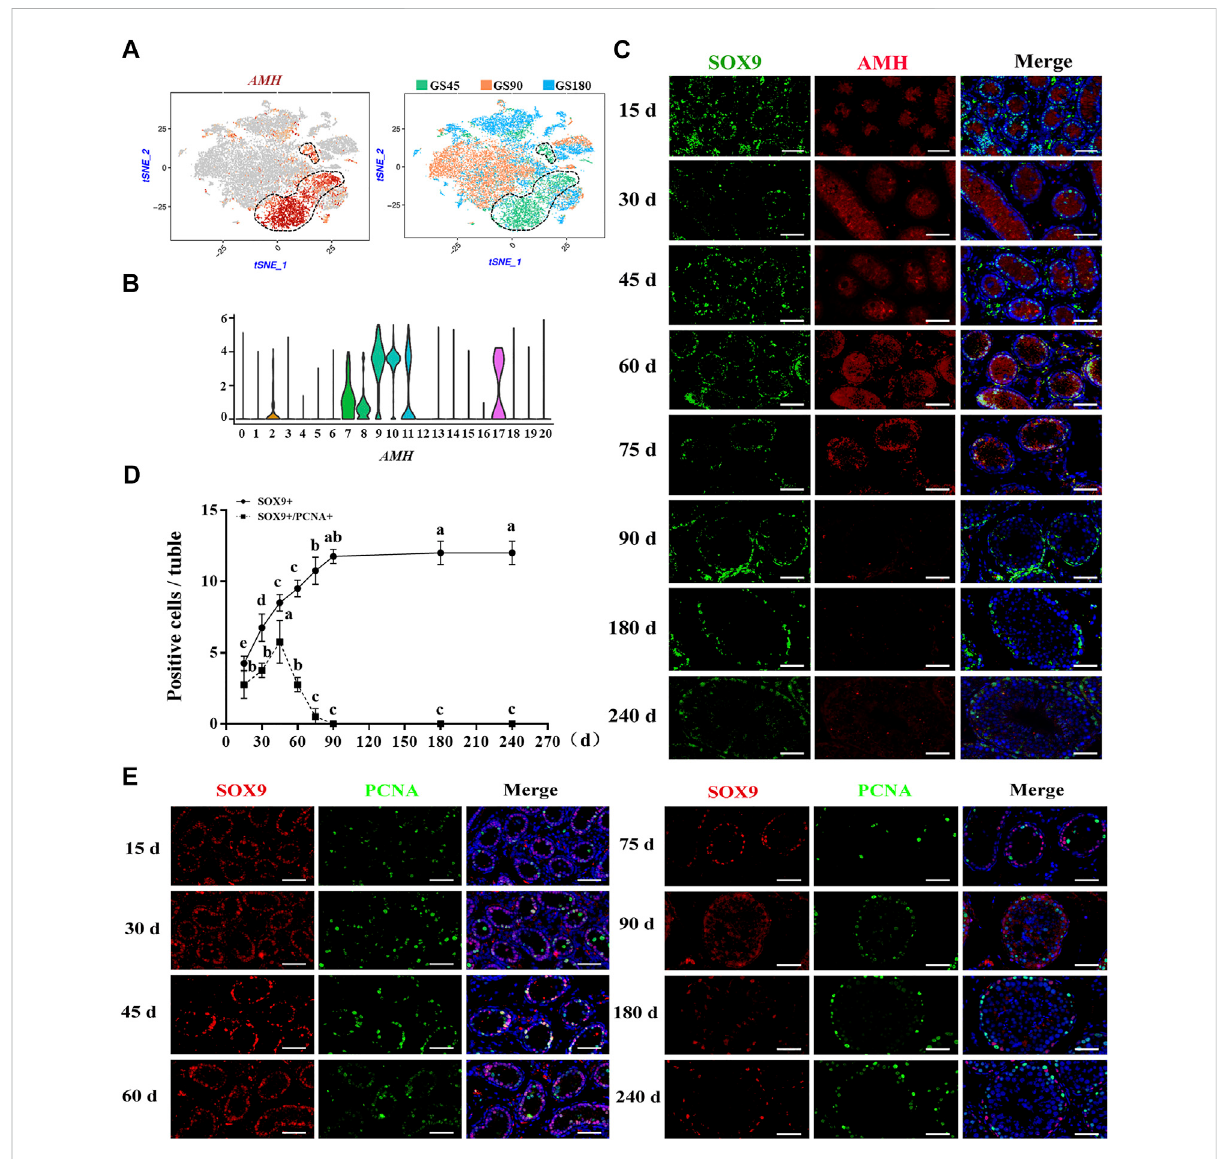
FIGURE 6 Sertoli cells development in dairy goat testes. (A) Expression patterns AMH for Sertoli cells visualized in t-SNE plots. (B) Expression patterns (violin plot)ofAMH thedifferentcluster. (C) AMHandSOX9 immunostainingofdairygoattestis sectionsateachage.Bar=100 μ M. (D) Thenumbers of SOX9/PCNA-positive cells per cross-section of seminiferous tubules in dairy goat testes at each age ( n = 9). Different letters imply signi fi cant difference( p < 0.05),andsamelettersmeannosigni fi cantdifference( p > 0.05). (E) SOX9andPCNAimmunostainingofdairygoattestissections at each age. Bar = 100 μ